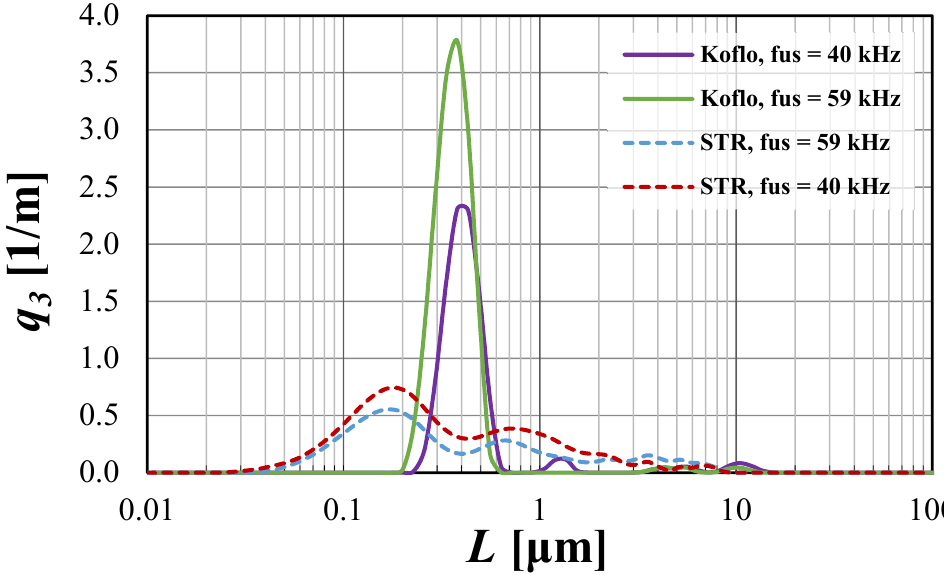
Figure 6. The influence of US frequency on particle density distribution q 3 for both examined reactor types.